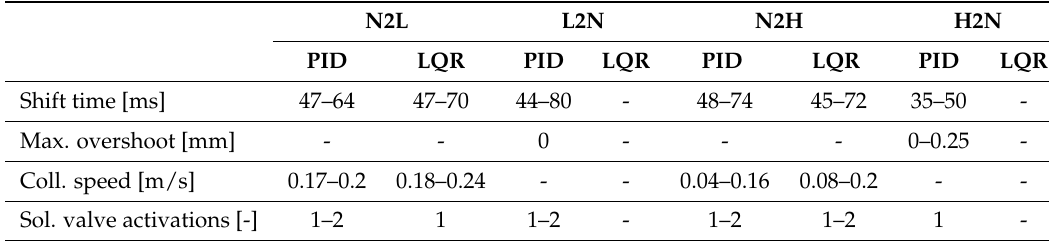
Table 5. Summary of the measured control